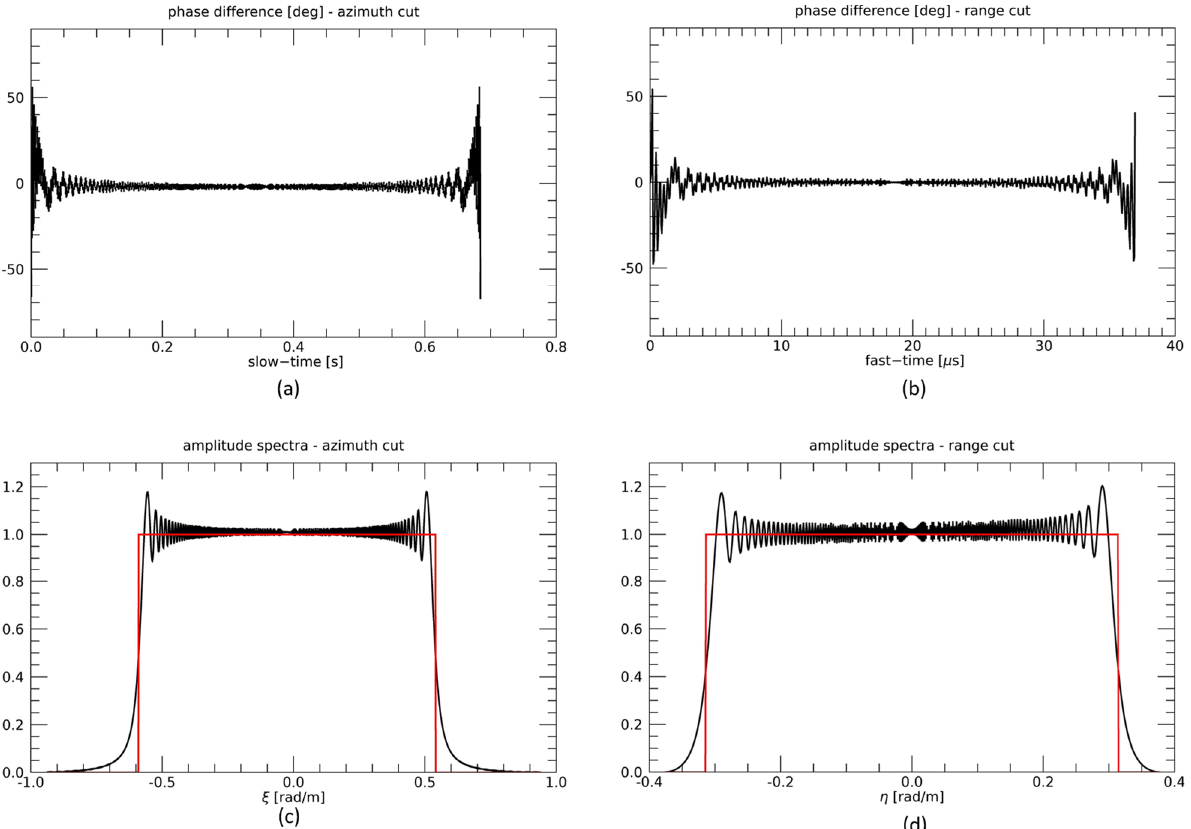
Figure 5. TI configuration, first example. Slow-time ( a ) and fast-time ( b ) cuts of the difference between the phases of the raw signals simulated in time and frequency domains. Slow-time ( c ) and fast-time ( d ) cuts of spectra of raw signals generated via the time (black line) and frequency (red line) domain simulators.